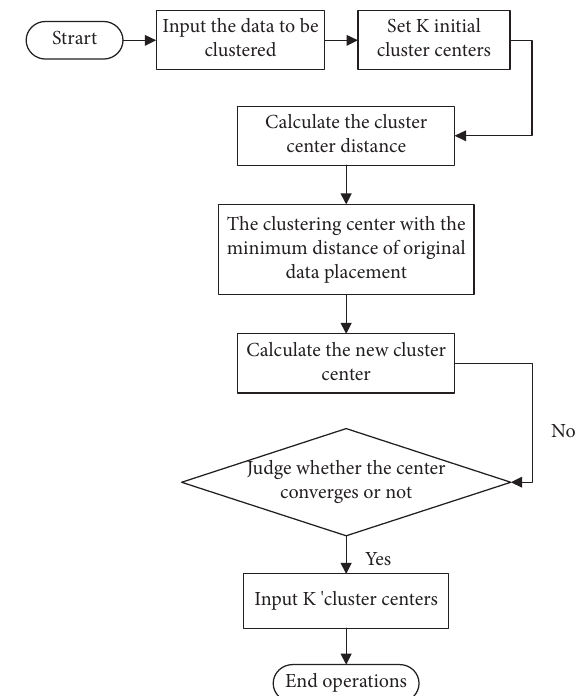
Figure 2: The process of determining the cluster center